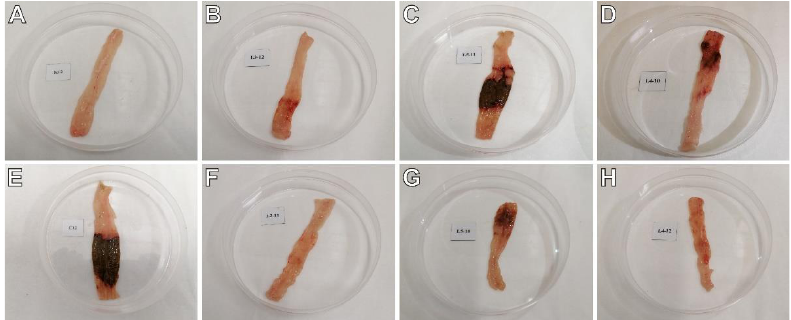
Figure 1. The gross appearance of the colon specimens revealed that compound 7b (10 and 20 mg/kg) and compound 13b (20 mg/kg) reduced macroscopically visible mucosal damage induced by TNBS. Control group ( A ); group receiving only TNBS ( E ); group receiving 10 mg/kg compound 7b and TNBS ( B ); group receiving 20 mg/kg compound 7b and TNBS ( F ); group receiving 10 mg/kg compound 10b and TNBS ( C ); group receiving 20 mg/kg compound 10b and TNBS ( G ); group receiving 10 mg/kg compound 13b and TNBS ( D ); group receiving 20 mg/kg compound 13b and TNBS ( H ).